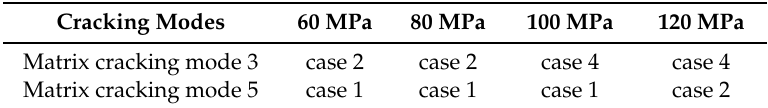
Table 1. The interface slip type of matrix cracking mode 3 and mode 5 corresponding to different peak stresses of cross-ply C/SiC composite.